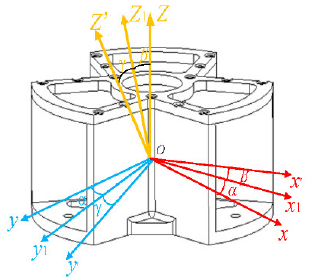
Figure 3. Attitude transformation of the passive docking mechanism establishing coordinate system oxyz. 2. Space Space docking coordinate system.